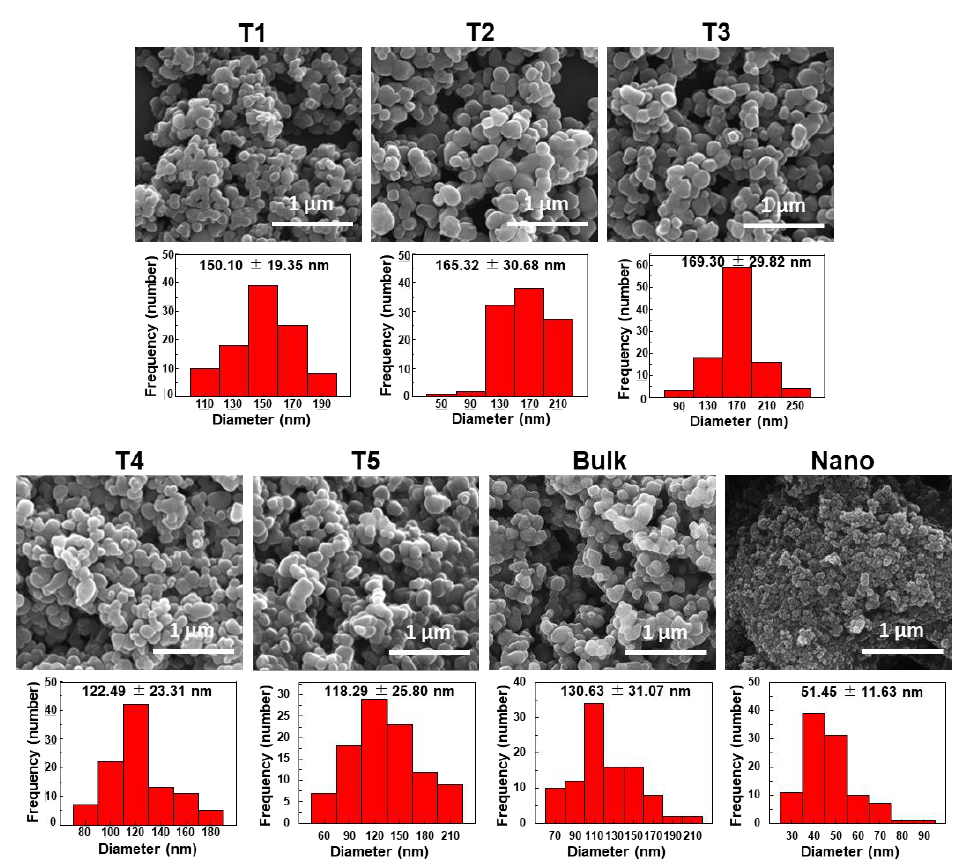
Figure 1. Scanning electron microscopy (SEM) images and size distributions of commercially available food additive TiO 2 (T1–T5) and general-grade bulk and nano TiO 2 (bulk and nano). Size distributions were obtained by randomly selecting 100 particles from the SEM images. Table 1. Primary particle sizes and size distributions of food additive TiO 2 (T1–T5) and general-grade bulk and nano TiO 2 (bulk and nano) measured by SEM.